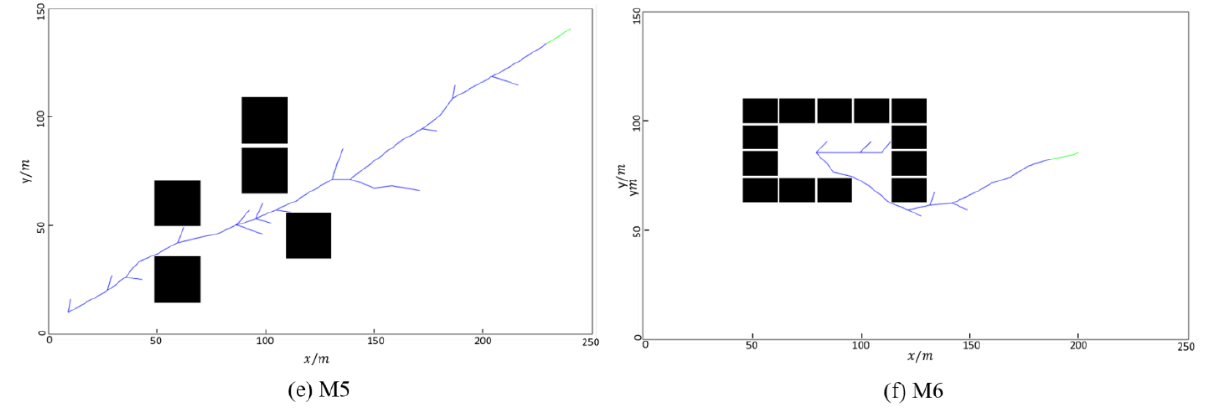
Figure 6. The best path planning of simulation results for different test environments.